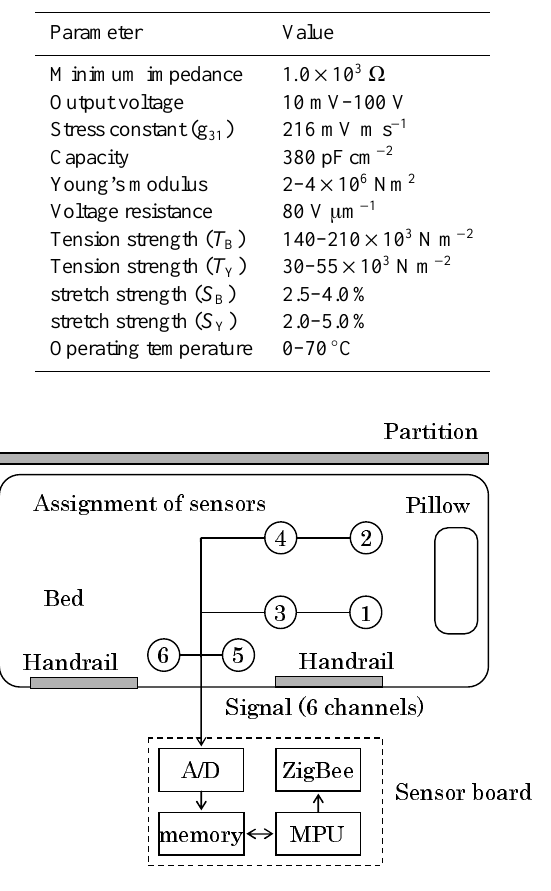
Figure 3. Block diagram of our system and assignment of sensors on a